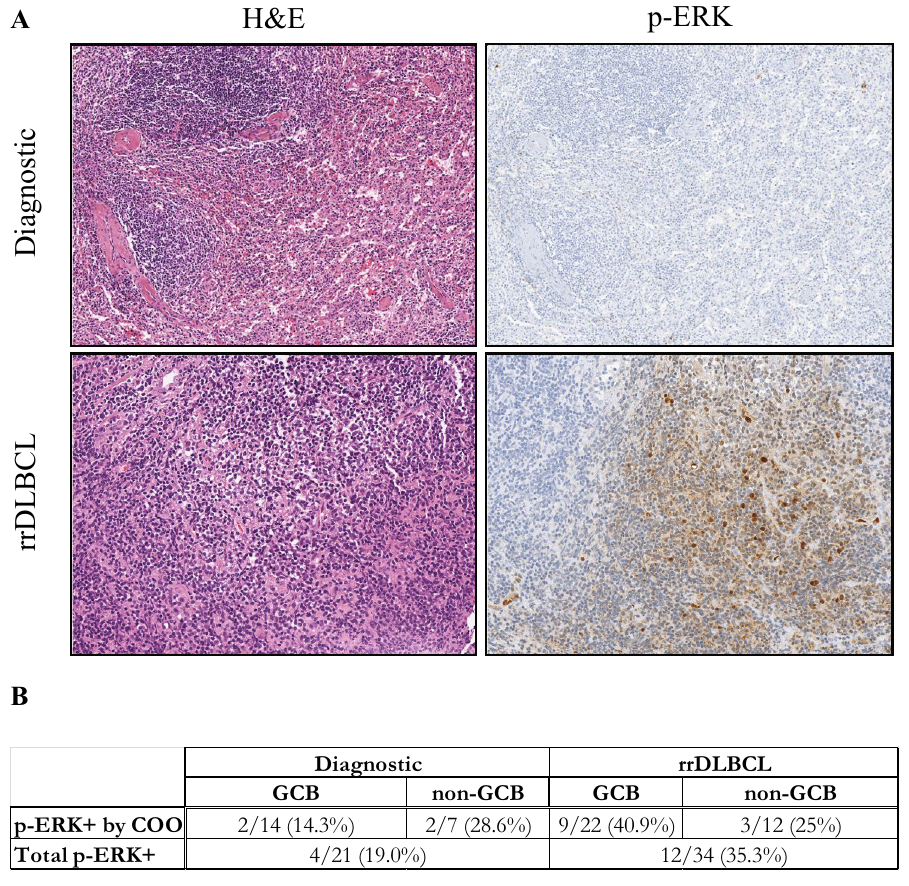
Figure 1. ( A ) Representative images of p-ERK in matched pairs of diagnostic and rrDLBCL samples. ( B ) Gain of phosphorylation of ERK in rrDLBCL tissues compared to diagnostic DLBCL tissues, including matched paired